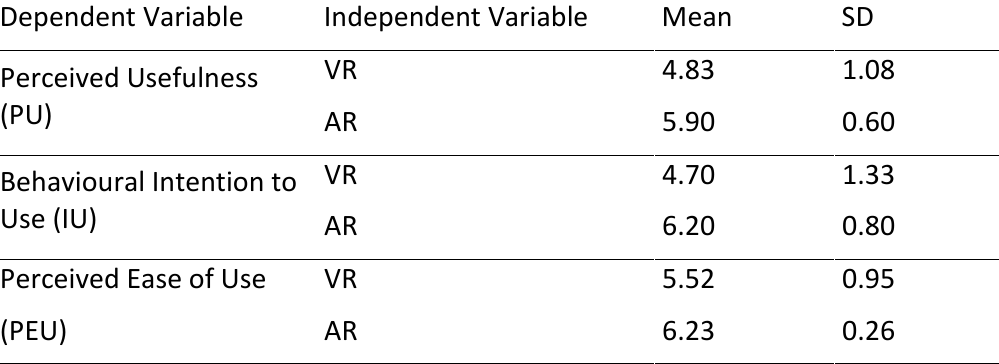
Table 2 . Descriptive Statistics for the Virtual and Augmented Reality Interfaces